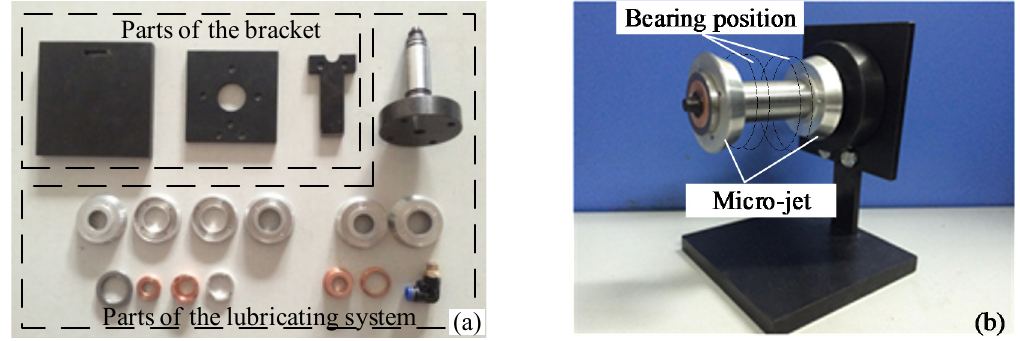
Figure 13. The experimental device of the piezoelectric micro-jet lubricating system: ( a ) The parts of the device; ( b ) The assembly of the device.